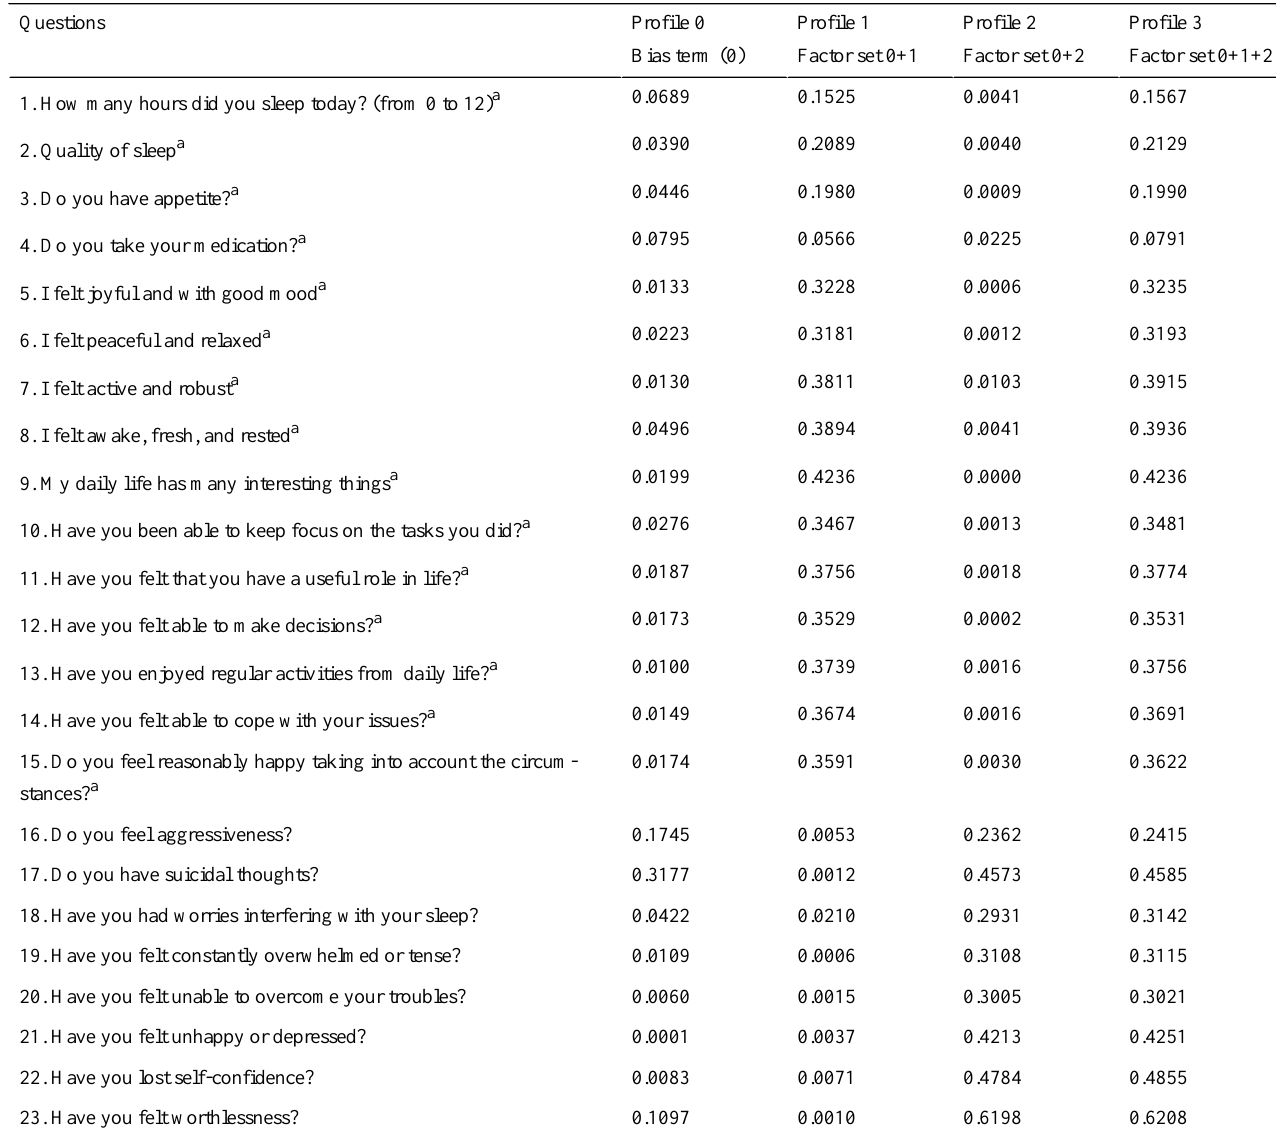
Table 2. Average score for each item in the self-reported questionnaire of current mental well-being according to the β matrix of factor